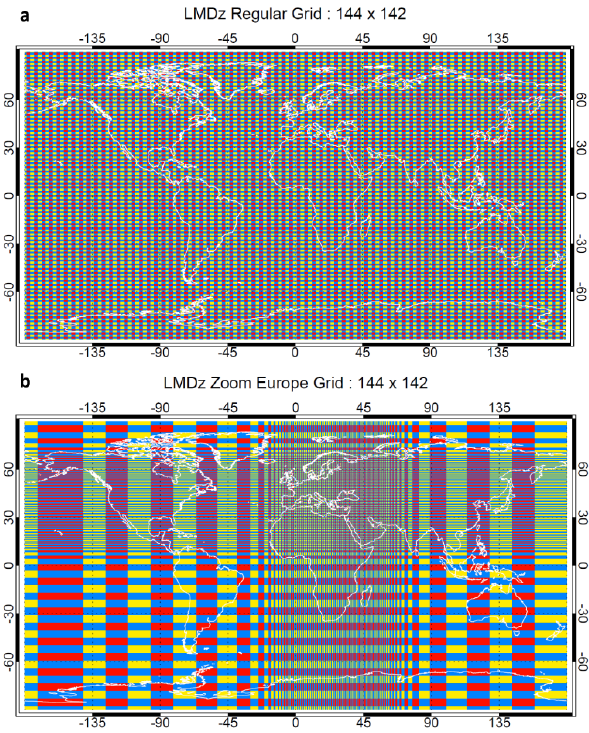
Fig. 1. (a) 144 × 142 (points) regular grid of the GCM used for the simulations of the Chernobyl accident using 19 and 39 sigma-p vertical layers, (b) 144 × 142 grid “stretched” over Europe (zoom- version) for 19 vertical